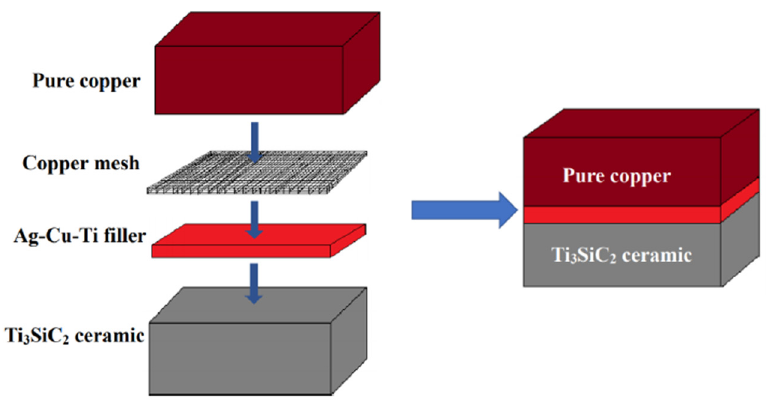
Figure 1. Assembly scheme of brazing sample.